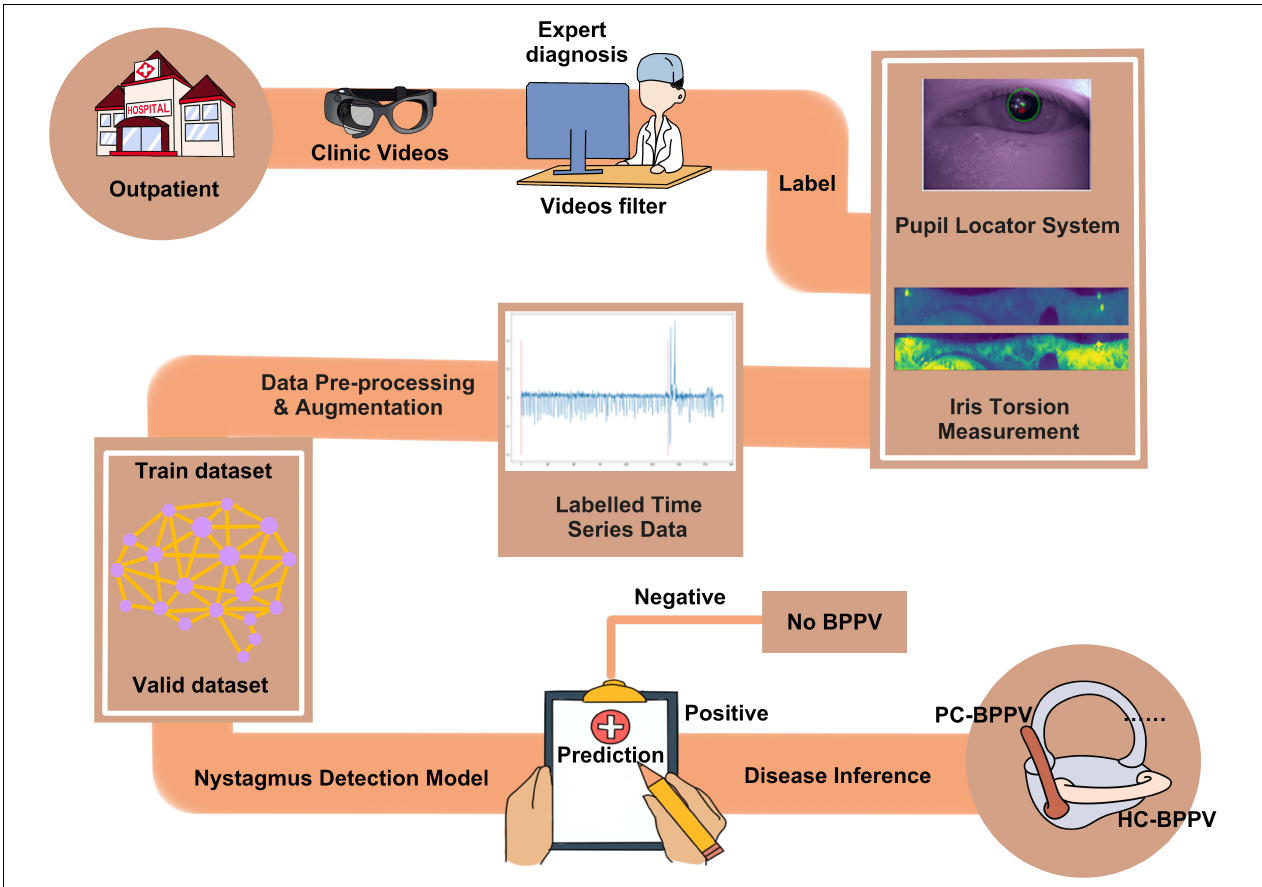
FIGURE 1 | Framework of the automatic nystagmus detection system. Procedures of our auto diagnosis system: pupil locator system, iris torsion measure, data pre-processing, CNN-based nystagmus detection model, and disease inference. CNN, convolutional neural